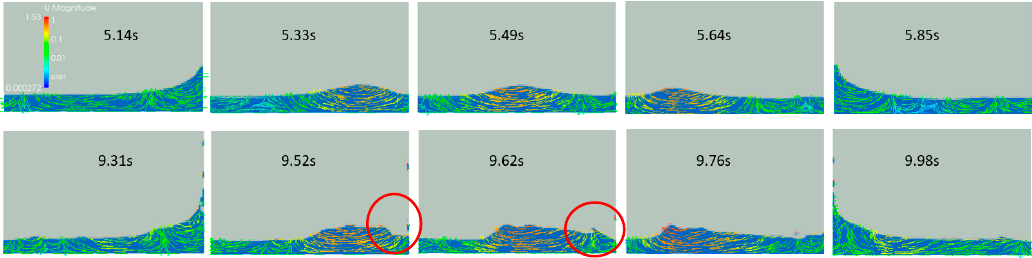
Figure 19. The comparison of pressure-–time history curve with wave breaking or not. (red line: wave breaking; black line: no wave breaking).